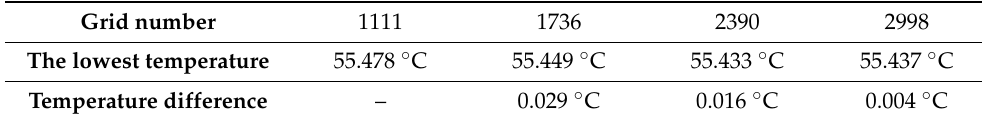
Figure 2. Illustration of the H-type fin: ( a ) mesh in computational domain; ( b ) temperature contour. Table 3. Grid independence test.